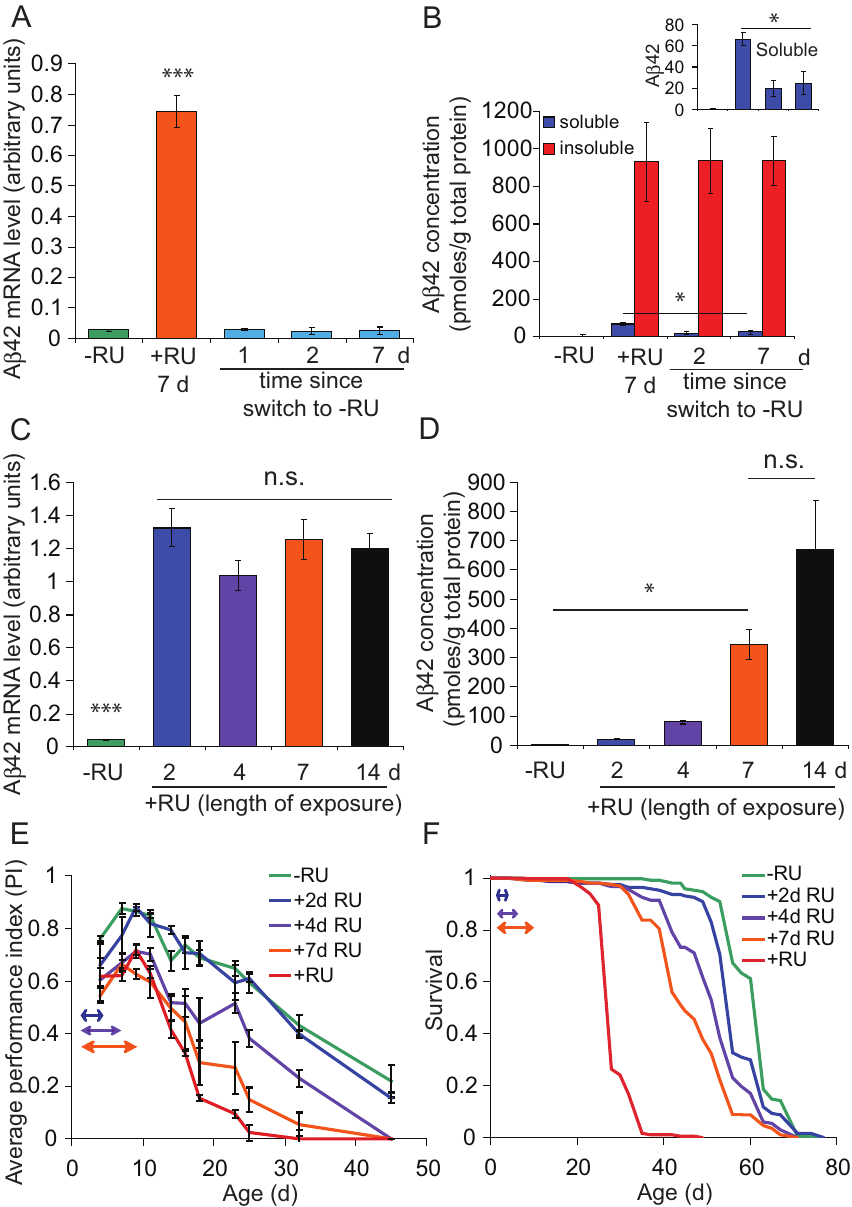
Figure 1. Effects of varying RU486 exposure time on A b 42 levels and toxicity. 2-day-old UAS-Arc A b 42/ + ; elavGS/ + females were treated with 200 m M RU486 for 2, 4, 7 or 14 days before being transferred to RU486-free medium (see table S1 for pulse conditions). Flies